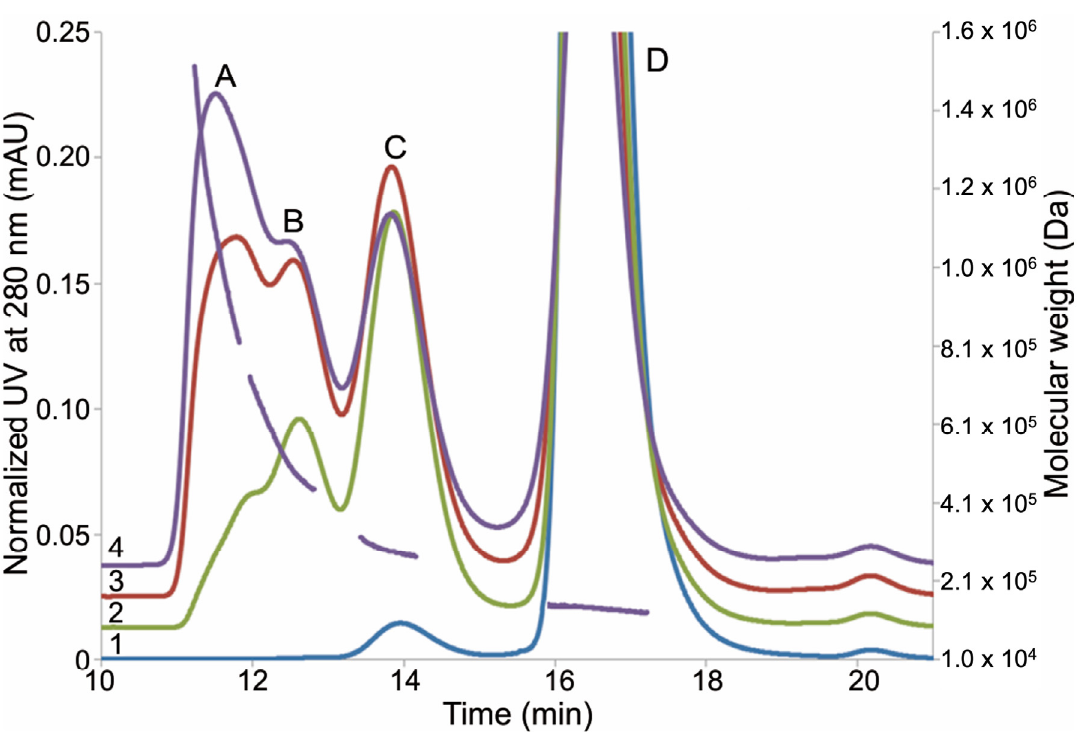
Figure 1. Expanded view of mAb1 size exclusion chromatography (SEC) profiles after 2,2 (cid:48) -azobis (2-amidinopropane) dihydrochloride (AAPH) stress. Chromatogram 1: control sample (mAb1 without the AAPH stress); chromatogram 2: mAb1 oxidized by 1 mM AAPH; chromatogram 3: mAb1 oxidized by 3 mM AAPH; 4: mAb1 oxidized by 5 mM AAPH. Molecular weights of peaks (A–D) for mAb1 oxidized by 5 mM AAPH are calculated and overlaid in the figure as the dashed line. Table 1. Size distribution of 2,2 (cid:48) -azobis (2-amidinopropane) dihydrochloride (AAPH)-stressed mAb1.